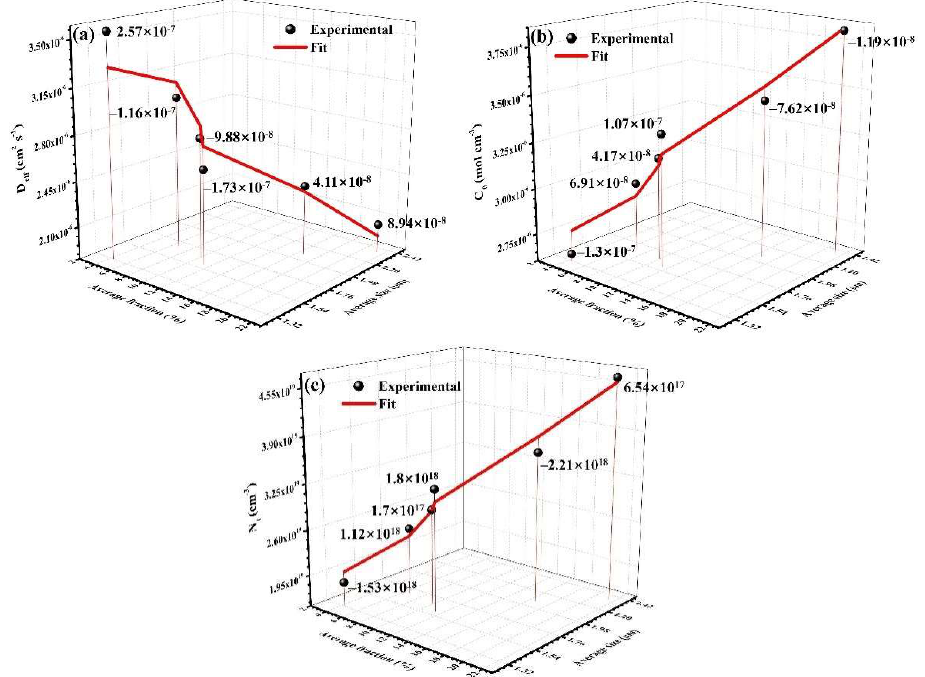
Figure 22. Fitting results of the functional relationship between D eff ( a ), C 0 ( b ), N t ( c ) and fraction of M/A constituents and average size.